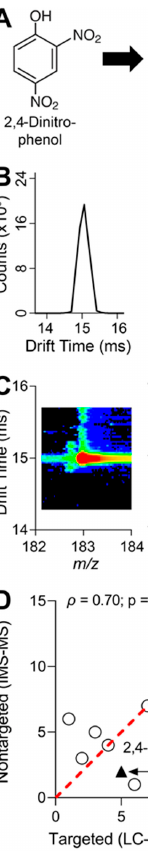
Figure 4. Metabolism pathway of 2,4-dinitrophenol (2,4-DNP), IMS-MS drift time chromatography of 2,4-DNP and major metabolite, and correlation of pesticides detected by targeted and nontargeted analyses: ( A ) Schematic of 2,4-DNP metabolism via sequential nitro group reduction to major metabolite, 2-amino-4-nitrophenol. ( B ) IMS-MS drift time vs. abundance (counts) chromatograms for 2,4-DNP (left panel) and 2-amino-4-nitrophenol (right panel). Data shown were generated by running analytical standards to obtain IMS drift time. ( C ) Plotted are IMS-MS drift time vs. mass-to- charge ratio spectra for 2,4-DNP (left panel) and 2-amino-4-nitrophenol (right panel). Drift time and mass-to-charge ratios were obtained by testing analytical standards. ( D ) Pair-wise ranked correlation (Spearman) plot of pesticides detected by targeted and nontargeted analyses (n = 12). For targeted and nontargeted analyses, each compound was ranked from highest (1) to lowest (12) in terms of in vitro clearance of 1 µ M mixture in iHep suspension. 2,4-DNP is denoted by the black triangle. Spearman ( ρ ) correlation value is shown in the graph with corresponding p -value. Red dotted line is a unit line. All data values for targeted and nontargeted clearance and ranked correlation analysis can be found in Table